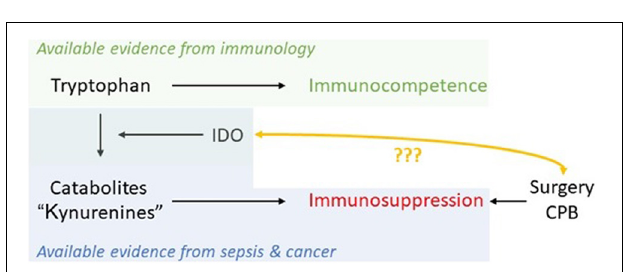
FIGURE 5 | Schematic of available evidence from different fields and the potential of IDO as a marker in the perioperative period to monitor immunosuppression caused by major trauma/physiological derangement such as cardiopulmonary bypass (CPB) in cardiac surgery.